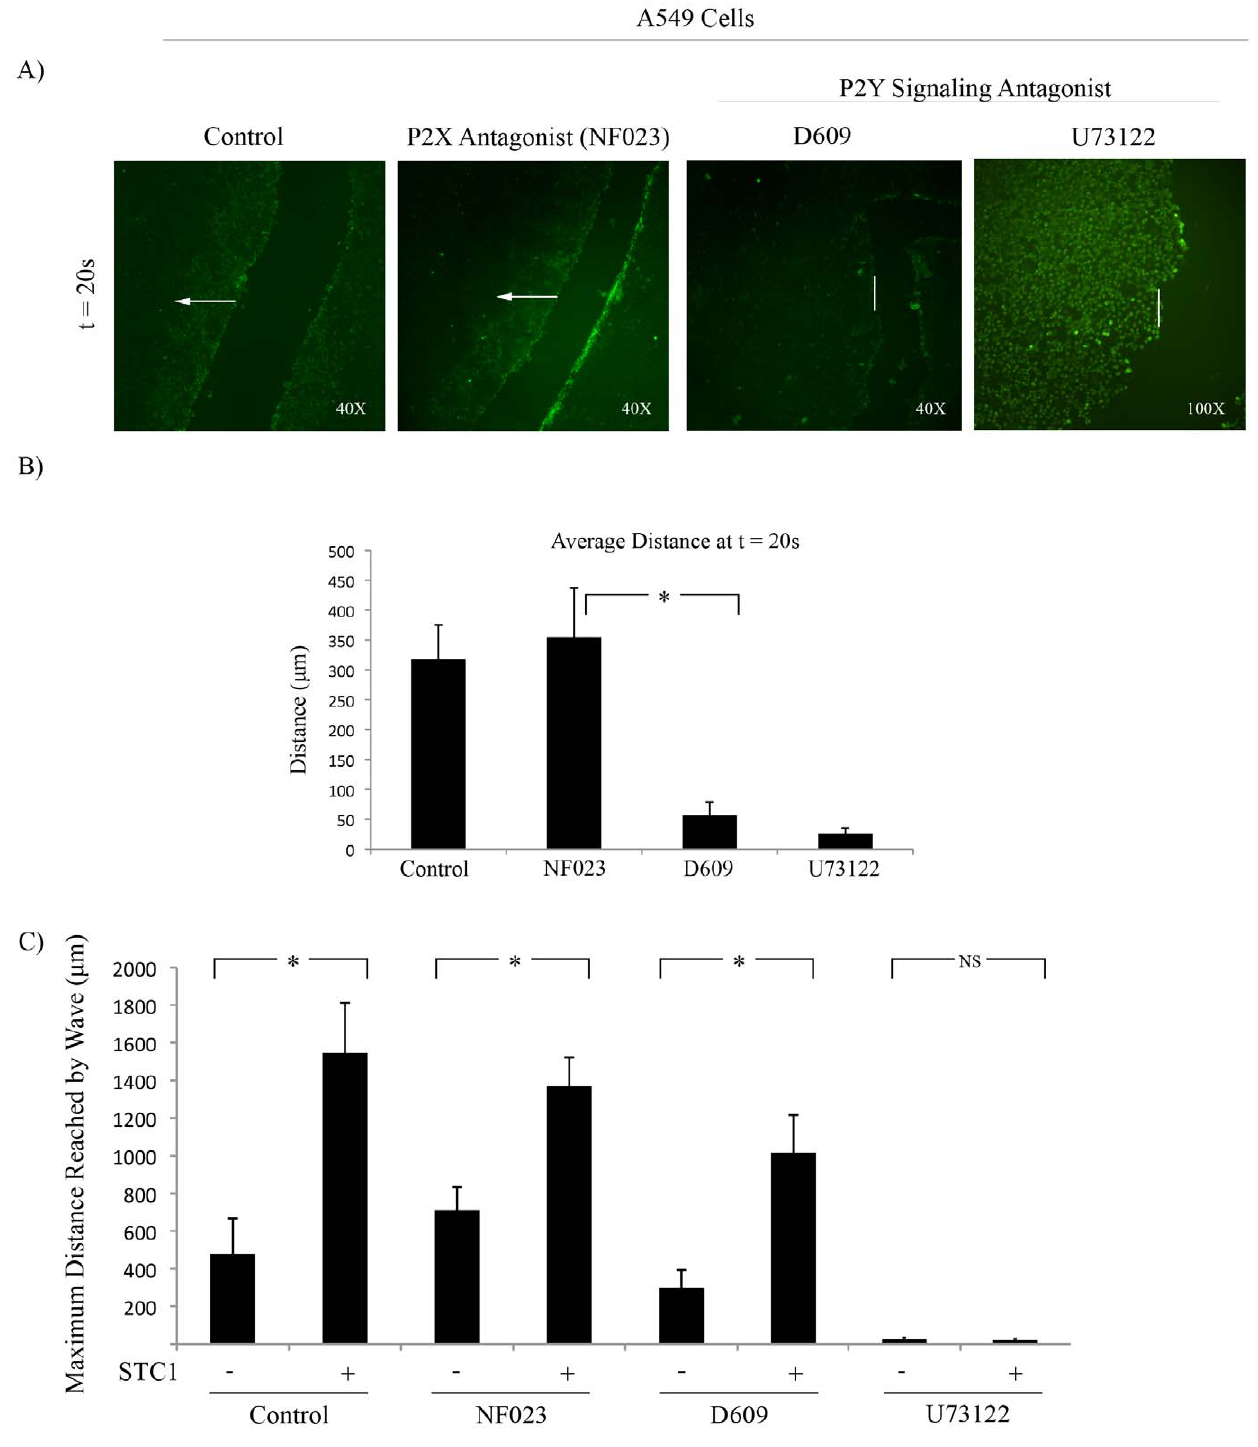
Figure 5. Inhibition of PLC Reduced Mechanical and ATP Induced Calcium Response. A) Fluo-4 labeled A549 cells were mechanically stimulated in the absence (control) or presence of either a P2X inhibitor (50 m M NF023), PI-PLC pathway inhibitor (50 m M D609), or PLC inhibitor (12.5 m M U73122) t=20 s post-injury. n=5. B) Quantification of distance traveled by calcium wave from A at t=20 s. Error bars = SD. * = p , 0.05. n=5. C) Fluo-4 labeled A549 cells pre-treated for 30 min with NF023, D609, or U73122 were incubated with 500 ng/mL STC1 for 10 min prior to scrape. Maximum distance of the calcium wave is displayed. Error bars = SD. * = p , 0.05. n=3.